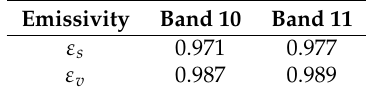
Table 3. Vegetation and soil emissivity values for Landsat-8 (OLI) band 10 and band